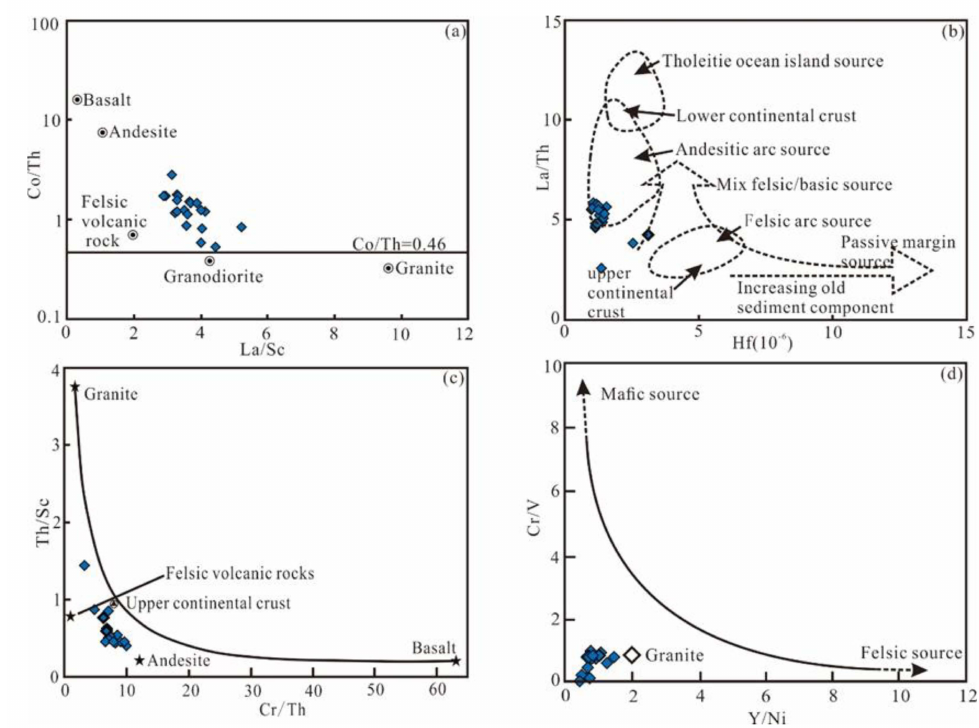
Figure 10. Source rock discrimination diagram for the Zhiluo Formation sandstones. ( a ) La/Sc versus Co/Th bivariate diagram [10], ( b ) Hf (ppm) versus La/Th bivariate diagram [42], ( c ) Cr/Th versus Th/Sc bivariate diagram [45] and ( d ) Y/Ni versus Cr/V bivariate diagram [10].